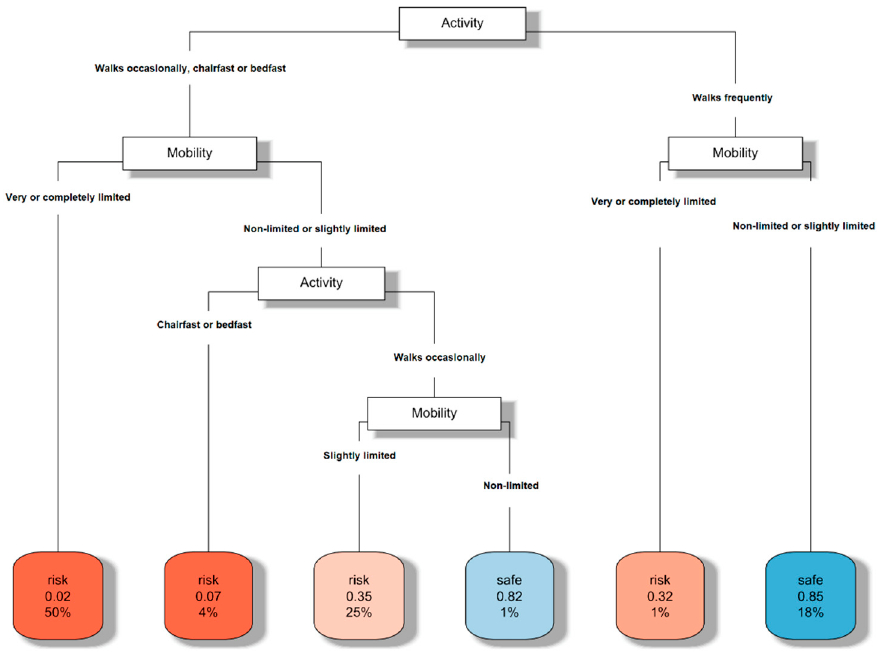
Figure 1. Decision tree for PU risk assessment based on activity and mobility.